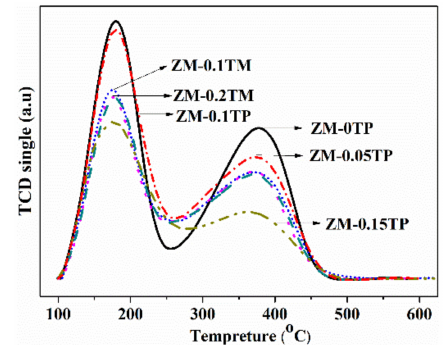
Figure 5. NH 3 -TPD profiles of the zeolite